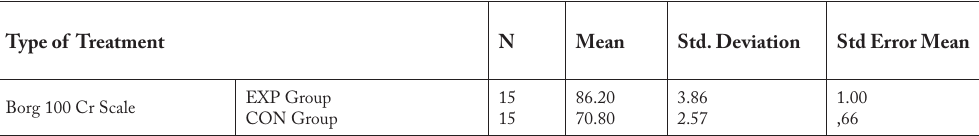
Table 2 . Difference between EXP and CON groups for perceived exertion scores. Group